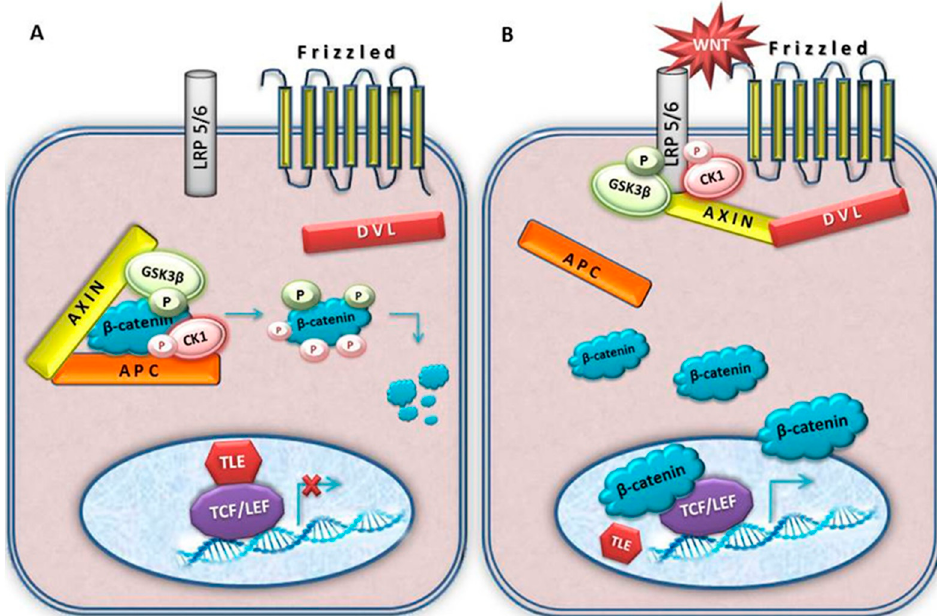
Figure 2. A schematic illustration of the canonical Wnt signal transduction cascade. Panel ( A ), in the absence of Wnt ligand, a destruction complex consisting of AXIN, APC, GSK3 ‐β and CK1 resides in the cytosol. β‐ catenin is phosphorylated by CK1 and GSK3 ‐β and targeted for degradation by the proteosomal machinery; Panel ( B ), with Wnt stimulation, some components of protein complex dislocate from the cytosol to the plasma membrane. The destruction complex falls apart and β‐ catenin is stabilized. Dvl is also recruited to the membrane and binds to Fz and Axin which is bound to phosphorylated LRP5/6. Stablized β‐ catenin is translocated to the nucleus where it associates to LEF/TCF transcription factors, displacing co ‐ repressor TLE and recruiting additional co ‐ activators to Wnt target genes. The activated Wnt pathway is associated to meningioma.